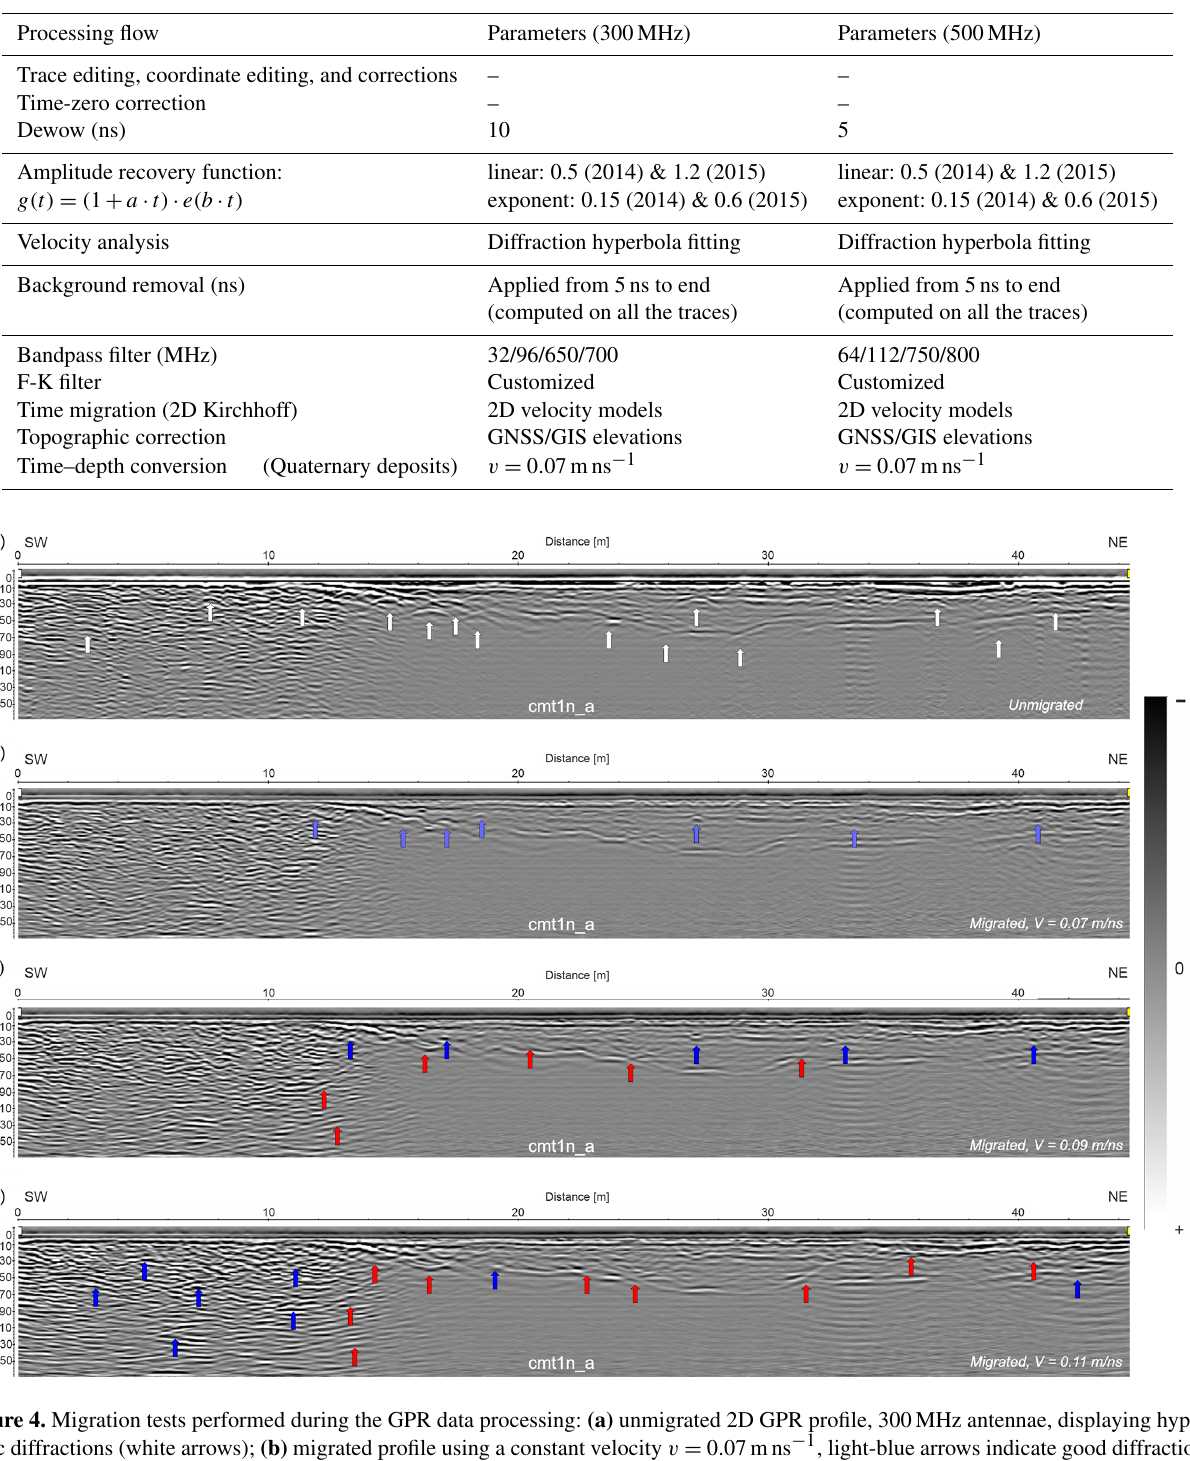
Table 2. Customized flow and details of the parameters used during the processing of the GPR dataset.